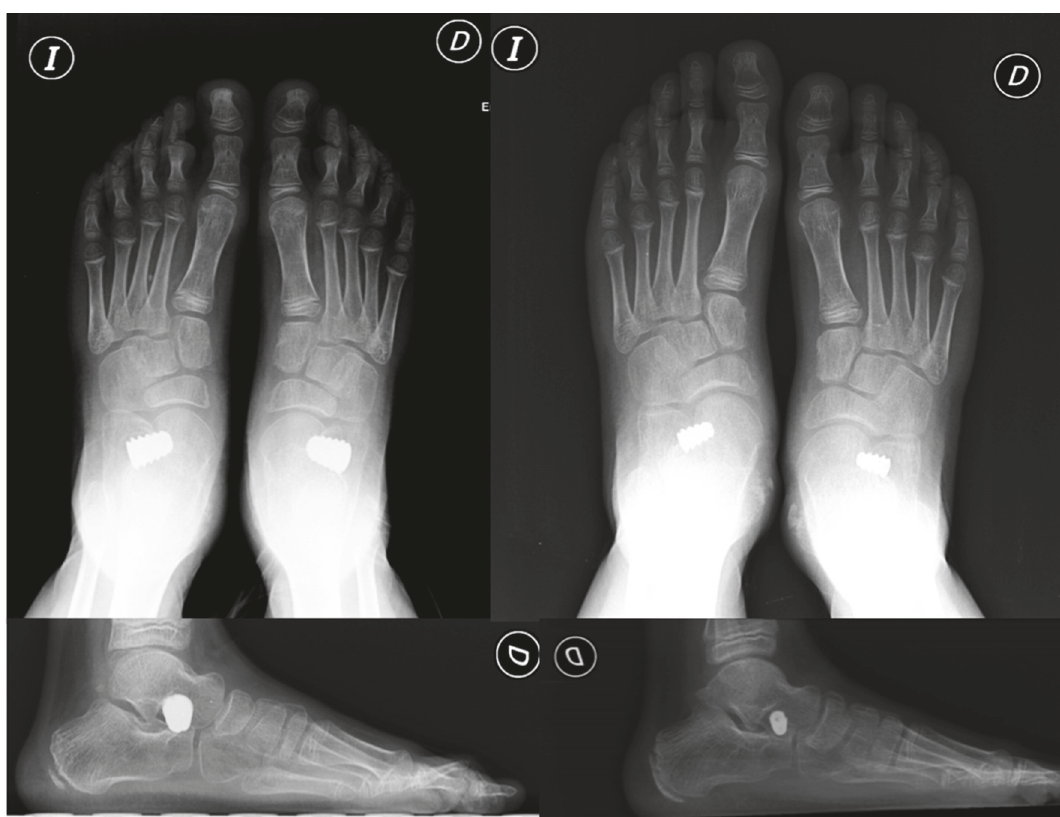
Figure 3: Example of overcorrection and expulsion of the implant. Revision surgery and placement of smaller-sized implants were necessary.